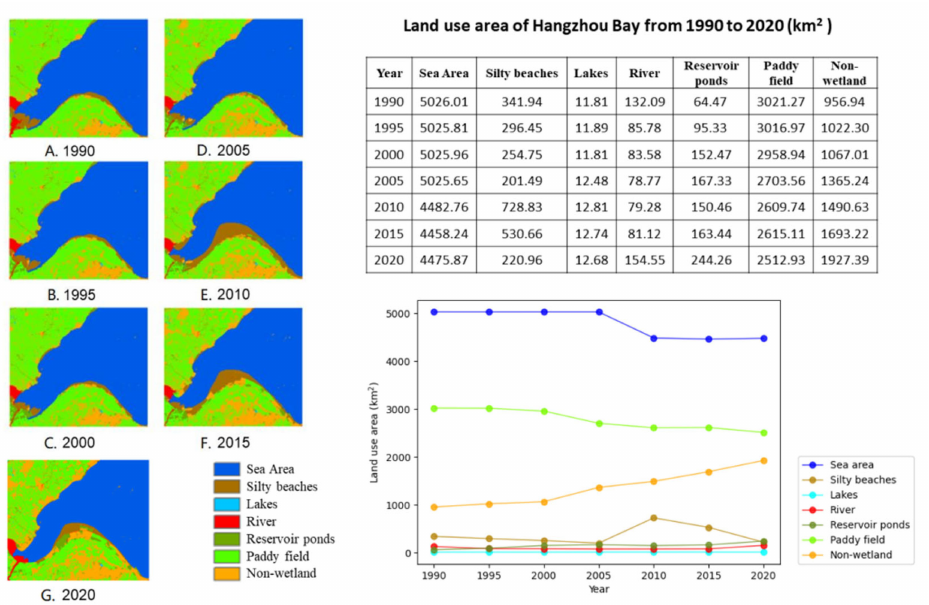
Figure 2. Land use/cover map of Hangzhou Bay wetlands from 1990 to 2020.